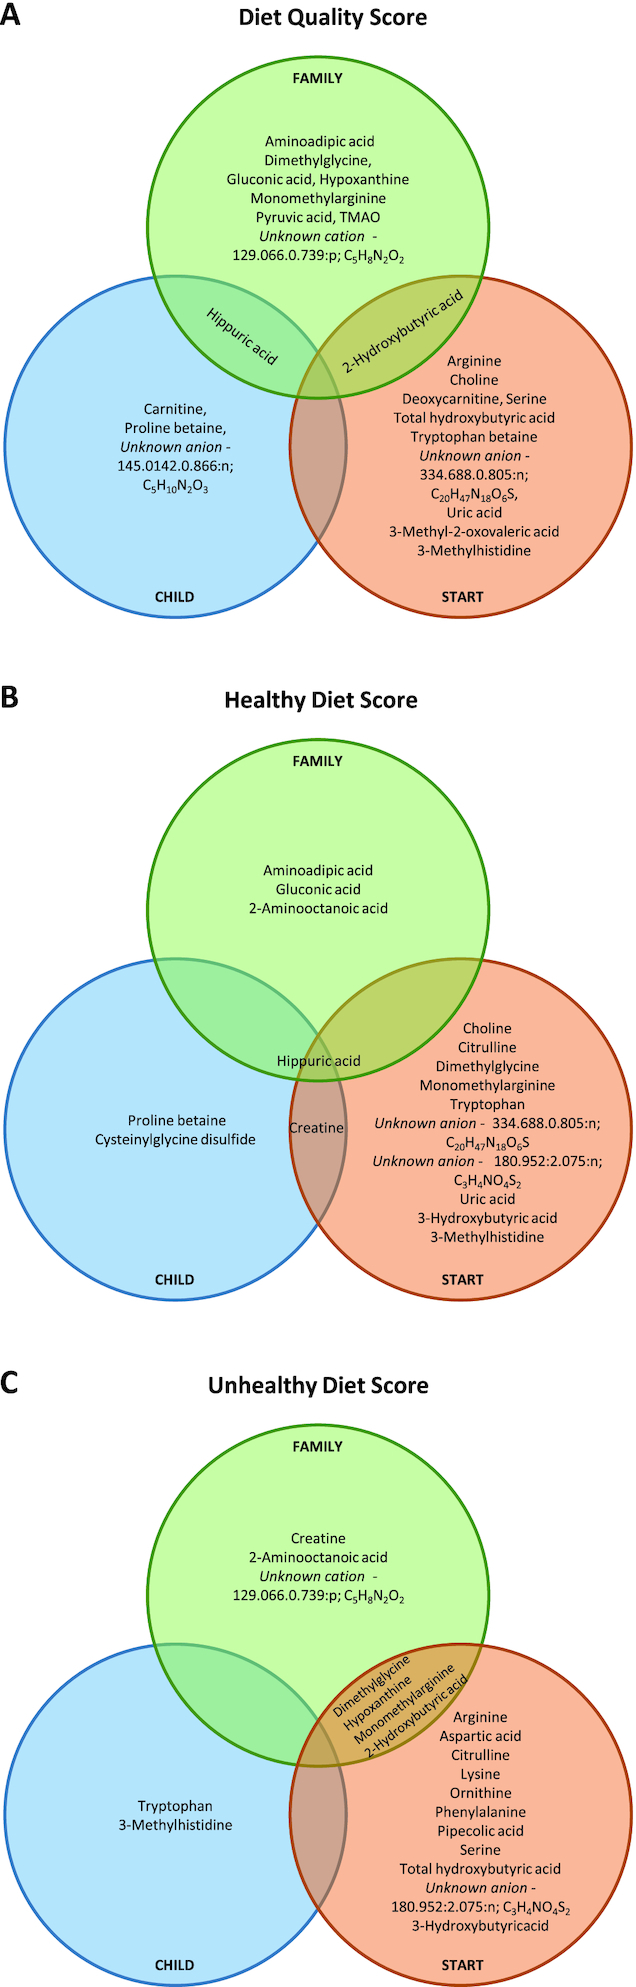
Venn diagram of metabolites that were significantly associated with Diet Quality Score (A); Healthy Diet Score (B); and Unhealthy Diet Score (C); adjusted for adjusted for prepregnancy BMI, gestational age, total energy intake, maternal age, and ethnicity. CHILD, Canadian Healthy Infant Longitudinal Development study; FAMILY, Family Atherosclerosis Monitoring In earLY life study; START, SouTh Asian biRth cohorT study; TMAO, trimethylamine N-oxide.